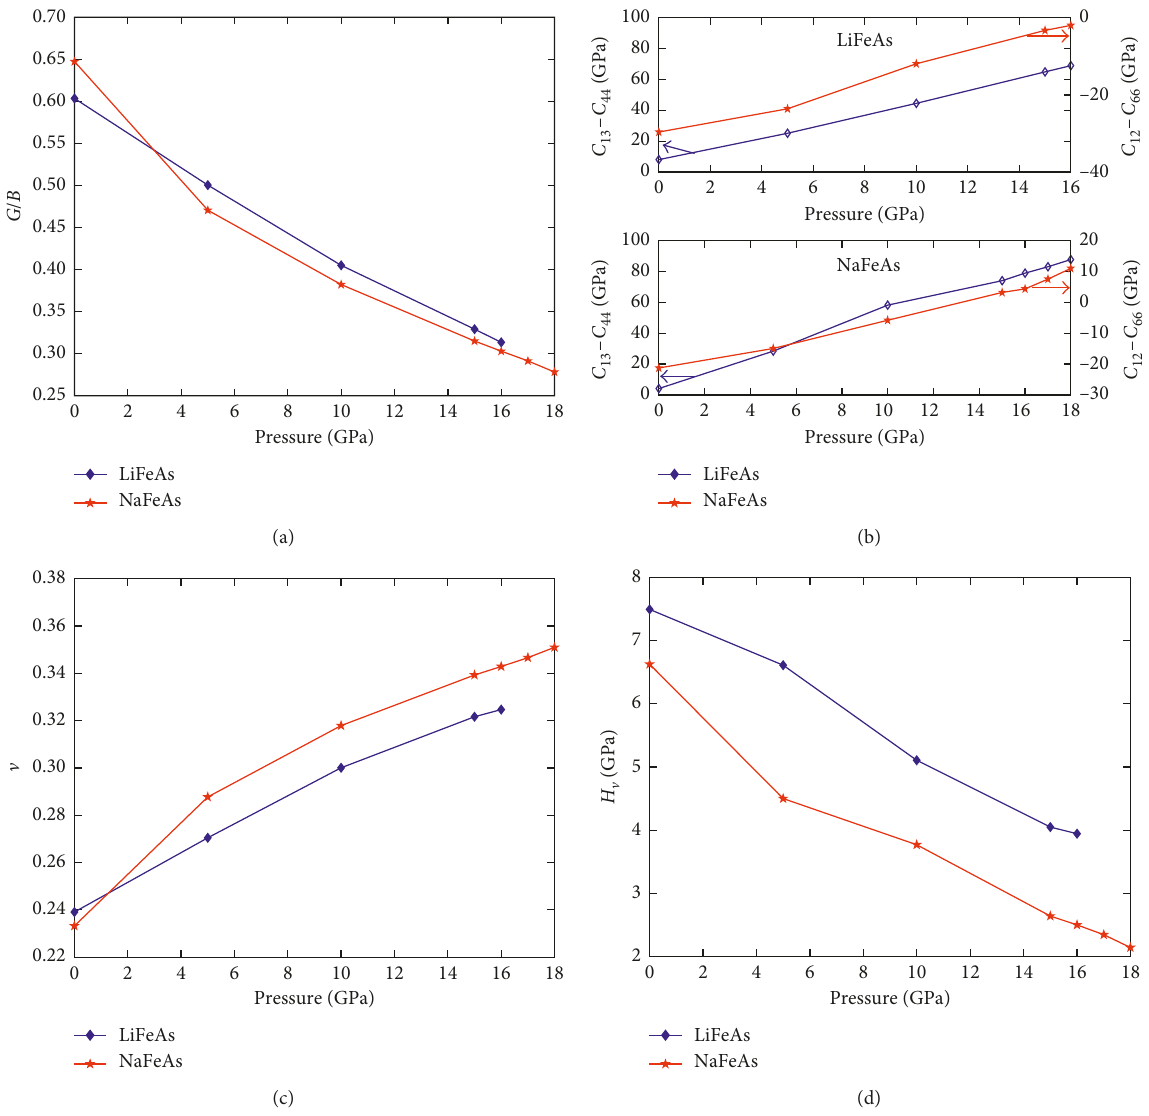
Figure 4: (a) The quotient of shear to bulk modulus G/B , (b) the Cauchy pressure, (c) Poisson’s ratio ] , and (d) the Vickers hardness H versus pressure for LiFeAs and